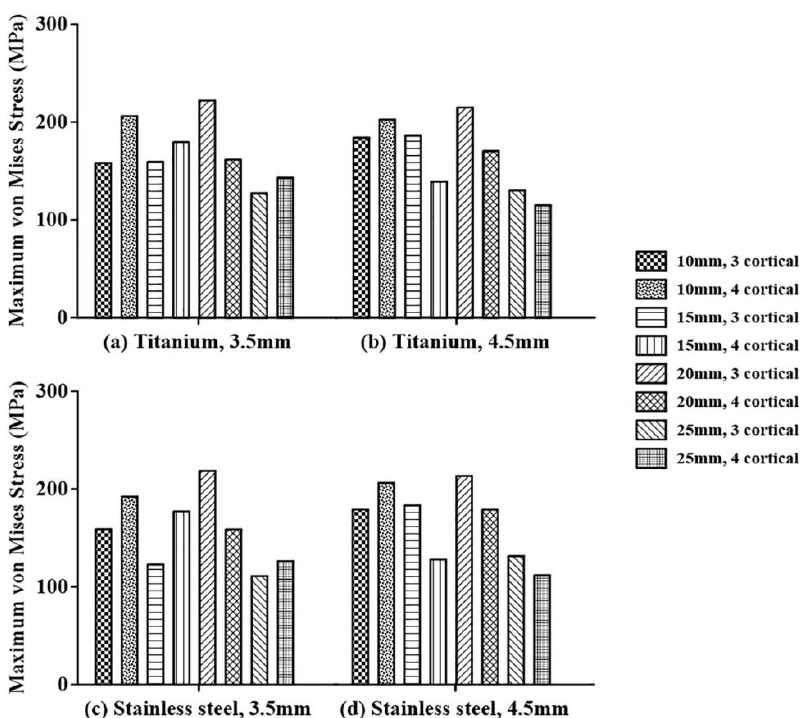
Figure 10. Analysis of the maximum von Mises stresses of the adjacent bone in terms of the diameter of the screw for: ( a ) titanium screw penetrating three cortical bones, ( b ) titanium screw penetrating four cortical bones, ( c ) stainless steel screw penetrating three cortical bones, and ( d ) stainless steel screw penetrating four cortical bones.